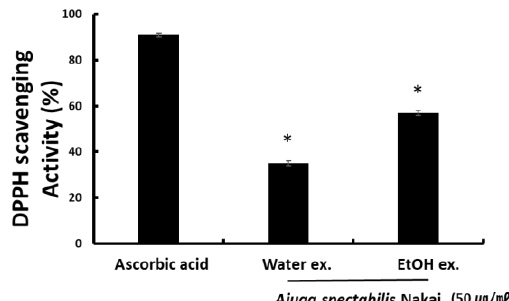
Figure 1. DPPH radical scavenging activity showing antioxidant effects of AS-W, AS-E. Data are presented as mean ± SD. * p < 0.05 compared with control.